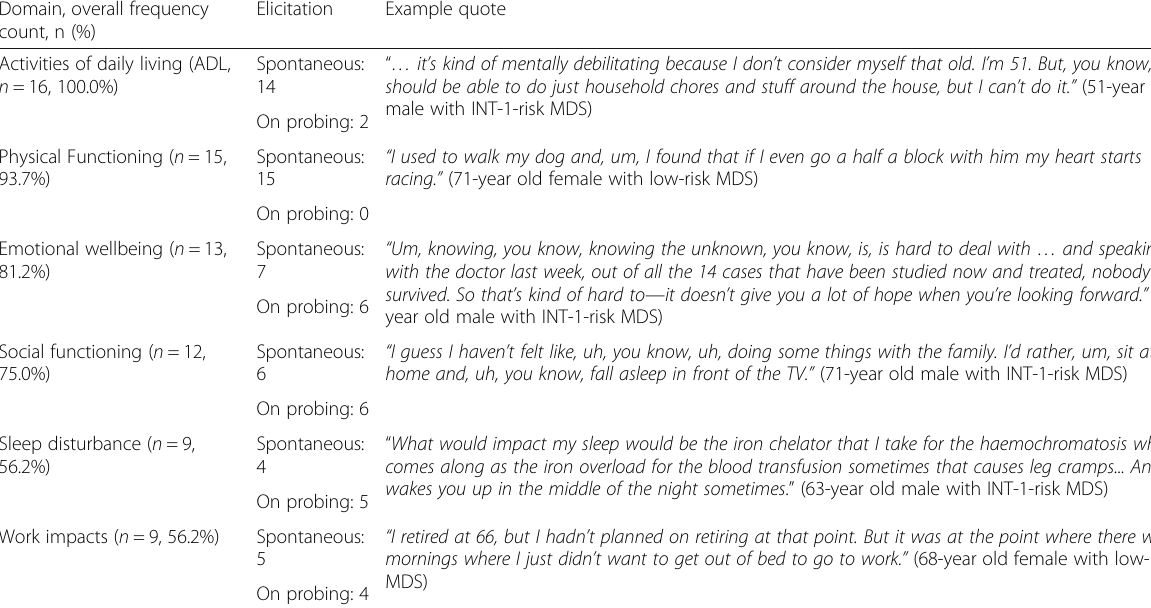
Table 3 Overview of impacts of MDS on functioning and health-related quality of life Domain, overall frequency count, n